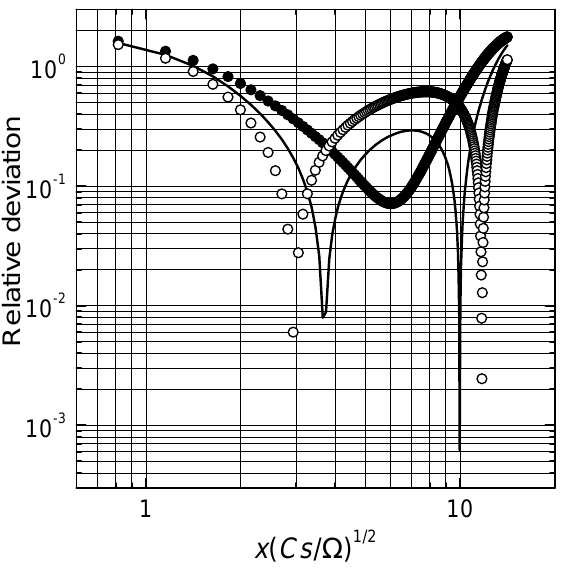
(cid:116) ) of the excited oscillation amplitude from that for the non-BNS p (cid:67)(cid:115) (cid:121) V . Solid line: (cid:116) (cid:48) (cid:173) (cid:49)(cid:46)(cid:53) ; solid damped solution ( z (cid:116) ) on (cid:120) circles: (cid:116) (cid:48) (cid:173) (cid:49)(cid:46)(cid:51) ; open circles: (cid:116) (cid:48) (cid:173) (cid:49)(cid:46)(cid:55) ; (cid:120) (cid:173) (cid:49)(cid:48)